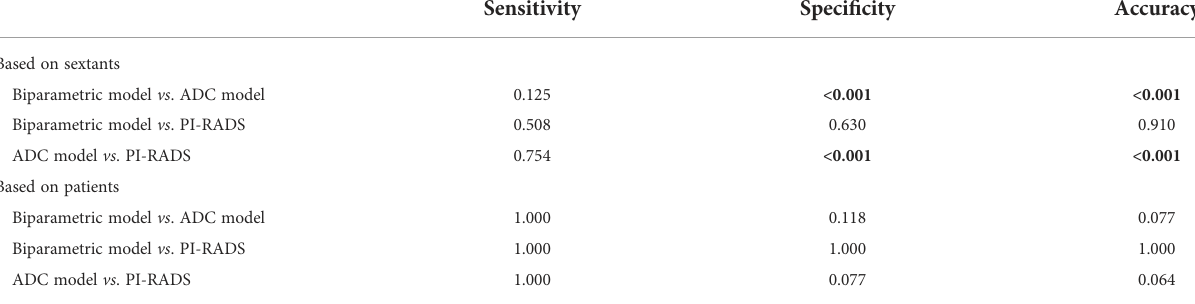
TABLE 5 Comparisons of the models and PI-RADS assessment based on sextants and